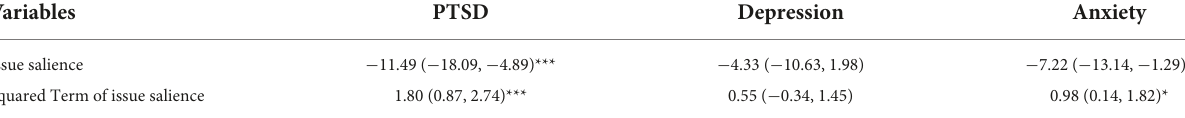
TABLE 3 Curve fitting with linear regression ( N =